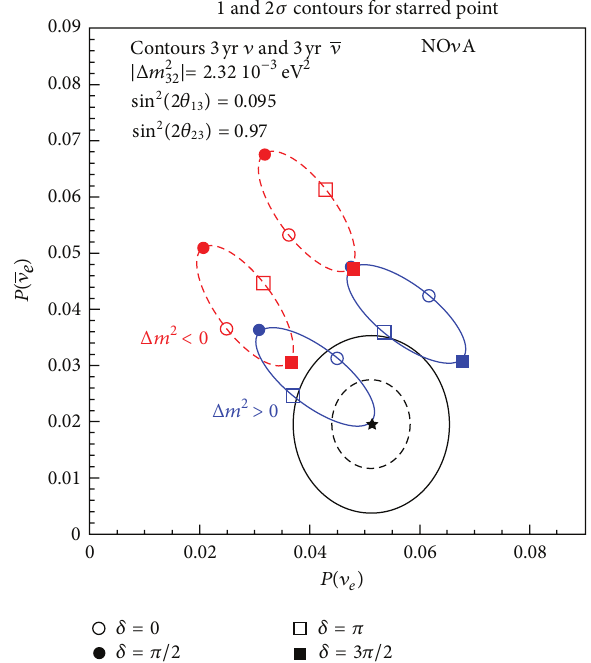
Figure 26: Biprobability plot for sin 2 (2𝜃 23 ) = 0.97 . See text for explanation.